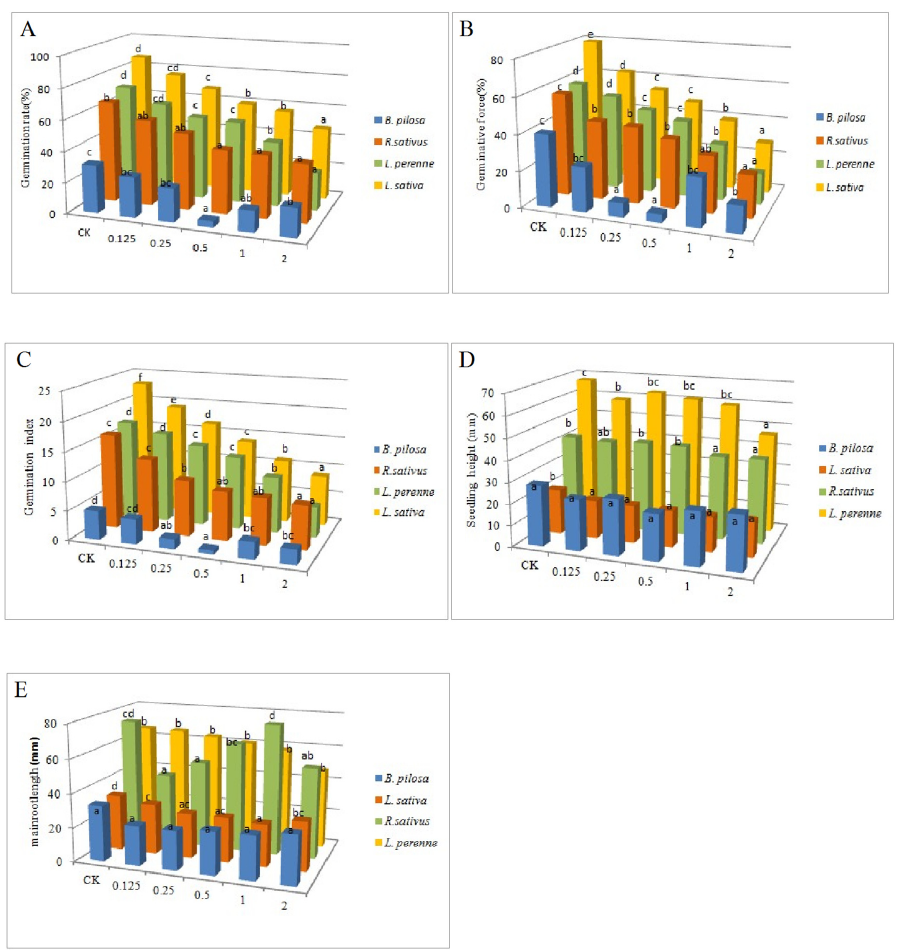
Figure 2. Effects of E. grandis × E. urophylla essential oil (EEO) at different mass concentrations on seed ( A ) germination rate, ( B ) germination force, ( C ) germination index, ( D ) seedling height and ( E ) the growth of roots. CK means blank control (1% Tween 80 solution). Error bars correspond to the standard error of each mean. For each observation day, means fol- lowed by the same letter (a–d) are not statistically different ((Tukey’s test p ≤ 0.05 ). Phytotoxic substances had high sensitivity and selectivity, and the sensitivity of phy- totoxic substances to different receptor plant phytotoxic effects was different [42]. Euca- lyptus essential oil had a certain phytotoxicity. E. camaldulensis oil significantly reduced E. bonariensis seed germination [43]. Li et al. found that essential oil from 17 cultivars Euca- lyptus strongly inhibits germination and growth of L. perenne [44]. Essential oils of E. salu-